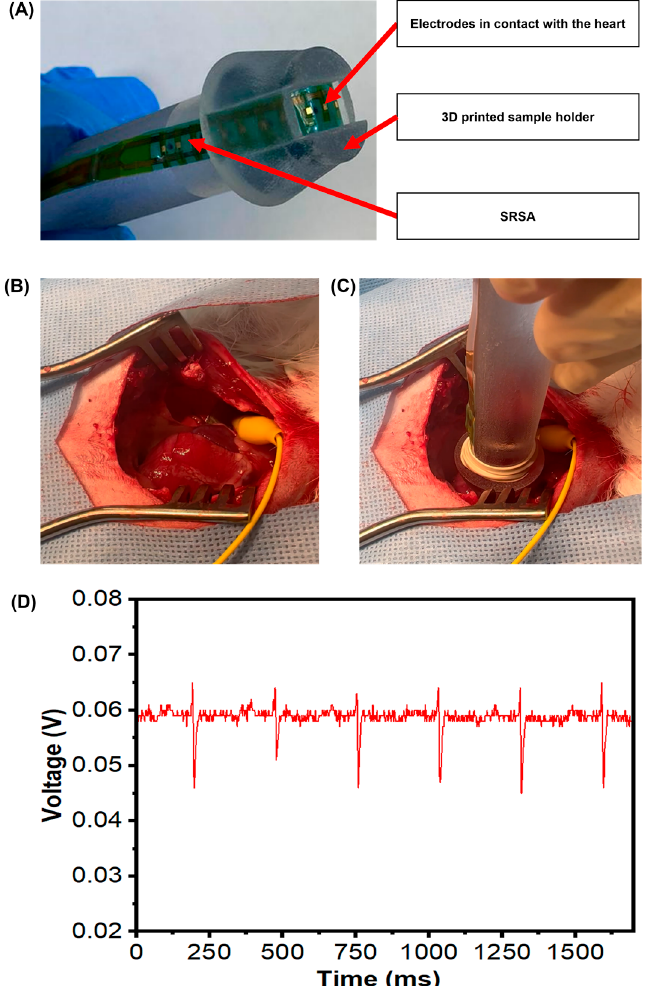
Figure 5. In vivo validation of electronic readings ( A ) flex-PCB SRSA mounted on a 3D printed sample holder. ( B ) Exposed leporine heart before collecting signals. ( C ) SRSA mounted on a 3D printed holder in contact with leporine heart. ( D ) Acquired signal using flex-PCB ENIG with a 500 Hz sampling rate.